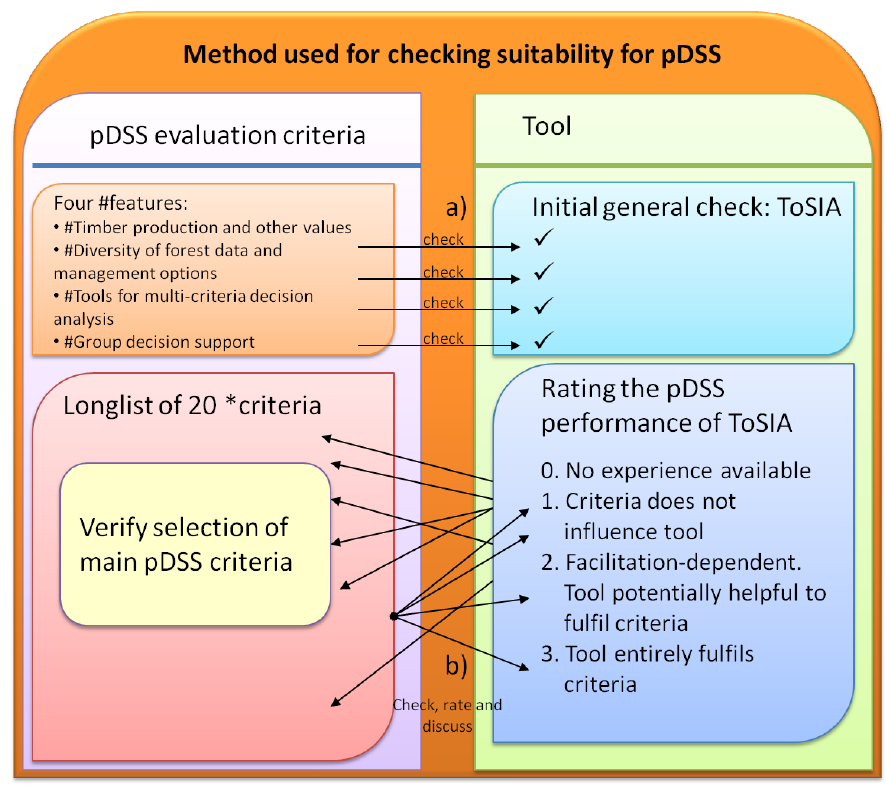
Figure 1. Stages used for checking the suitability of a tool, in this case ToSIA as a pDSS, building on Menzel et al.